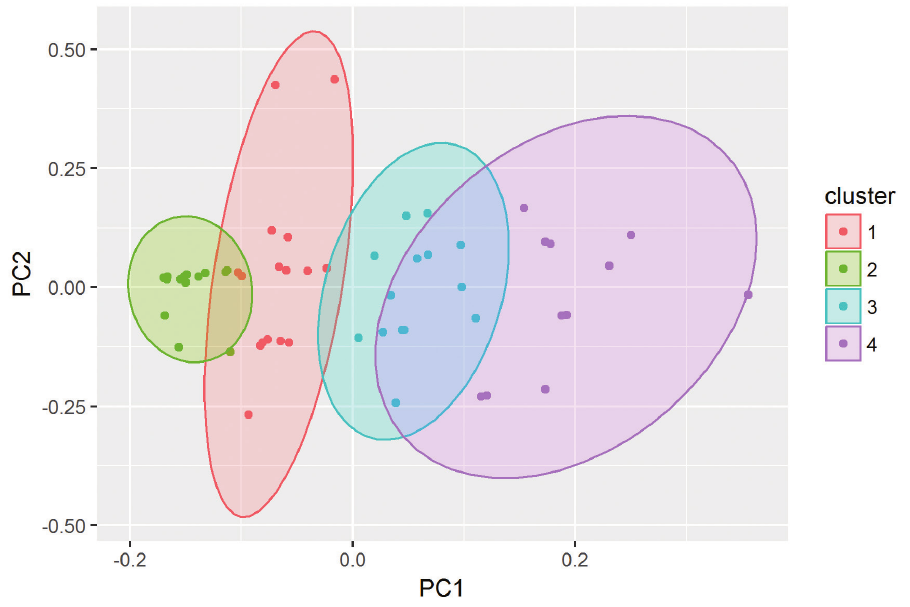
Figure 8. Ordination plot obtained by PCA on the environmental variables collected on the selected trees for the two sub-areas for each study area: FC and PA. The MANOVA test confirmed the dissimi- larities between the two study areas FC and PA, as shown by the limited overlap. Clusters correspond to different sub-areas: cluster 1 “Strada per Badia”, cluster 2 “Poggio Ghiaccione”, cluster 3 “Difesa di Pescasseroli” and cluster 4 “Val Fondillo. Table 4. Generalised Linear Models results. A ) Explanatory variables selection and final best model for count data of R. alpina in FC in 2016. For each model are reported the function used to build the model, AIC value and Delta AIC for selecting the best model, B ) Estimates and standard error (S.E.) of the